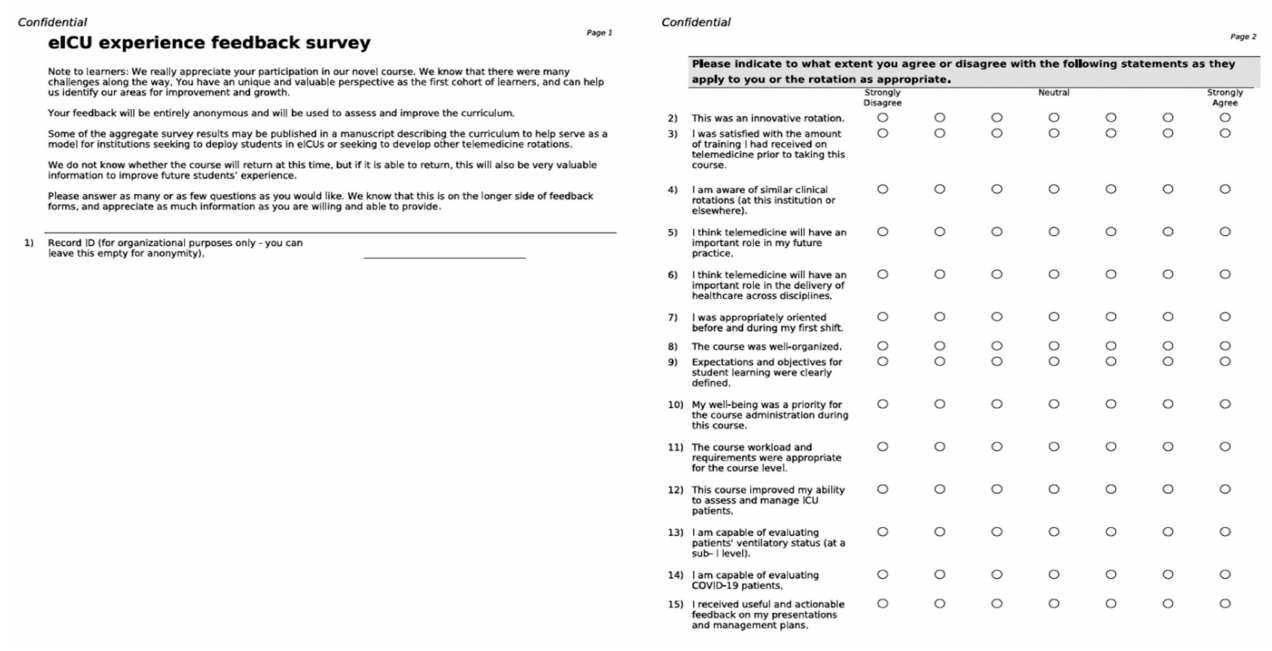
Figure A1. Student End-Of-Rotation Feedback.